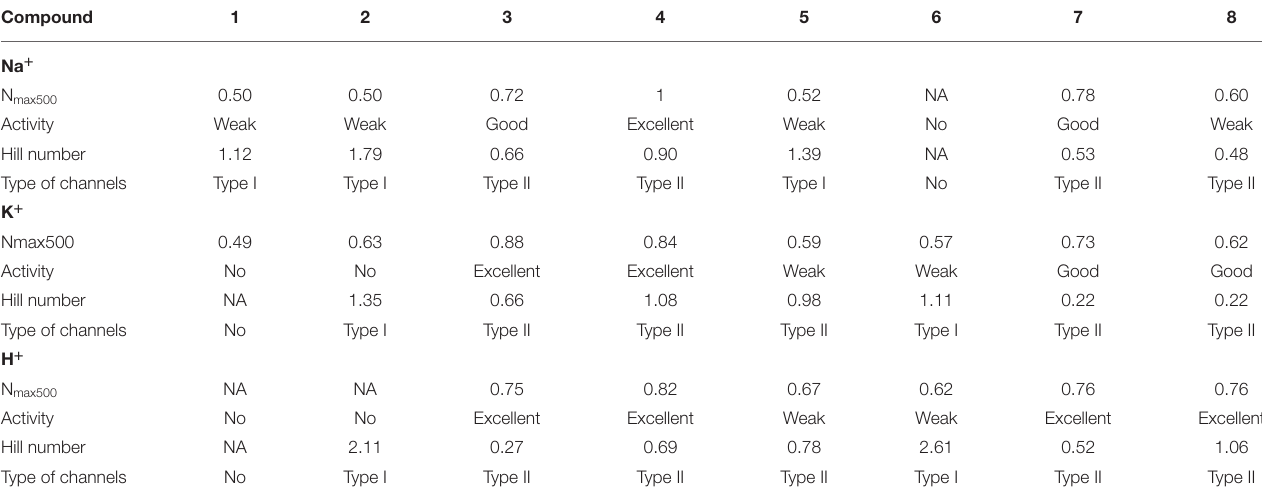
TABLE 1 | Hill analysis results of Na + , K + and H + transport with compounds 1-8 , in absence (Na + , K + ) or presence of Val (H + ). Compound